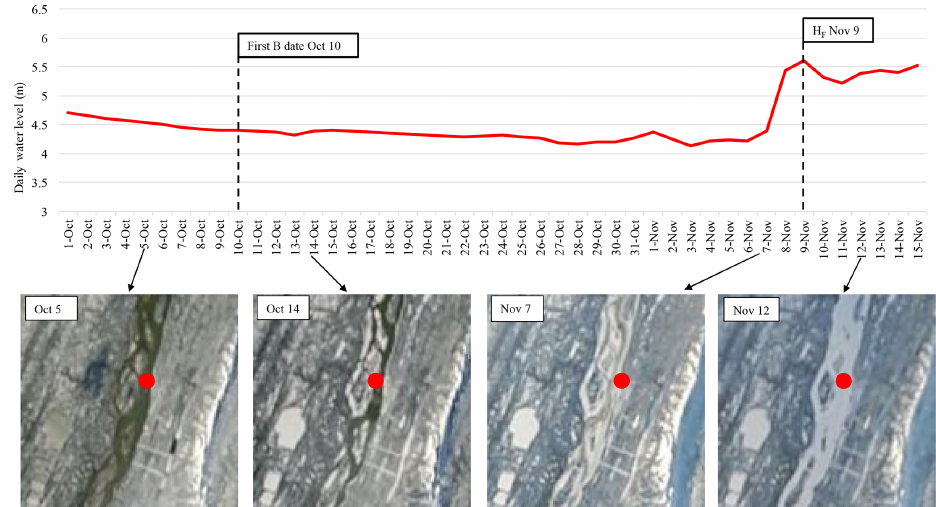
Figure 5. Daily mean water level hydrograph for 1 October to 15 November 2000 at National Hydrometric Program gauging station Macken- zie River at Norman Wells (10KA001), along with MODIS time-lapse satellite images (accessed at https://worldview.earthdata.nasa.gov/, last access: 20 July 2020). The station location is indicated by red circle. The width of the channel is approximately 1300m and includes numerous islands. Flow is from bottom to top. The first B date is 10 October, while the freeze-over water level (H F ) occurred on 9 November and these images were obscured by clouds. River channel open water is green and ice cover is white on these true-colour images.